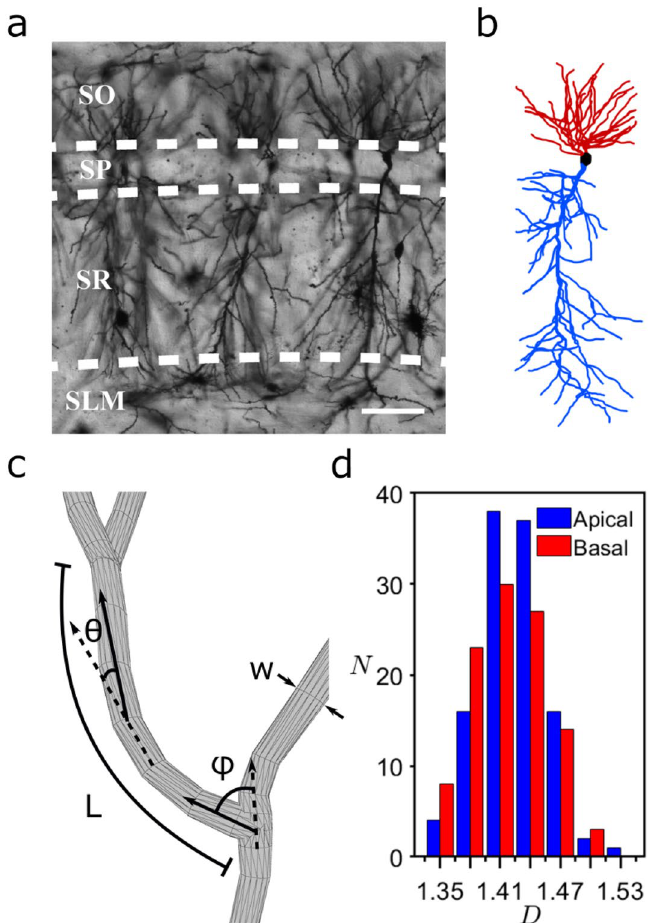
Figure 1. ( a ) An example confocal micrograph (x–y layer) showing three neighboring dendritic arbors, each spanning the oriens (SO), pyramidale (SP), radiatum (SR), and lacunosum-moleculare (SLM) strata of the CA1 region. The dashed lines represent the strata boundaries and the bar corresponds to 100 μm. ( b ) A three- dimensional model of a dendritic arbor (reconstructed from a stack of micrographs in the z direction using Neurolucida and displayed using MATLAB) featuring the apical (blue) and basal (red) arbors and the soma (black). The neuron’s axon arbor is not shown. ( c ) Schematic showing the neuron parameters L , W , Histogram of N , the number of neurons with a given D value, measured for the neurons’ apical and basal